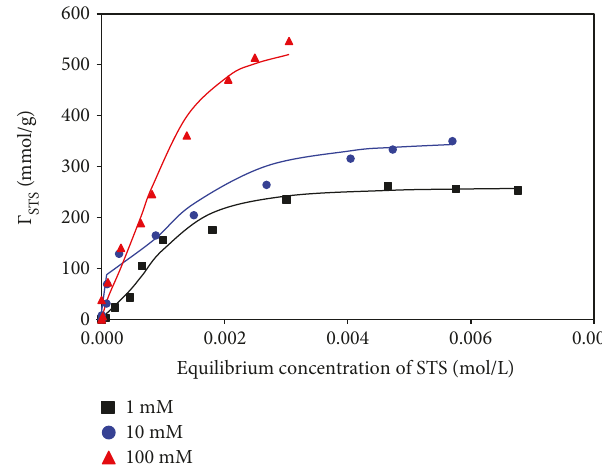
Figure 5: Adsorption isotherms of SDS onto γ -Al NaCl concentrations (pH 4). While the points are experimental data, the solid lines are the results of the 2-step adsorption model.